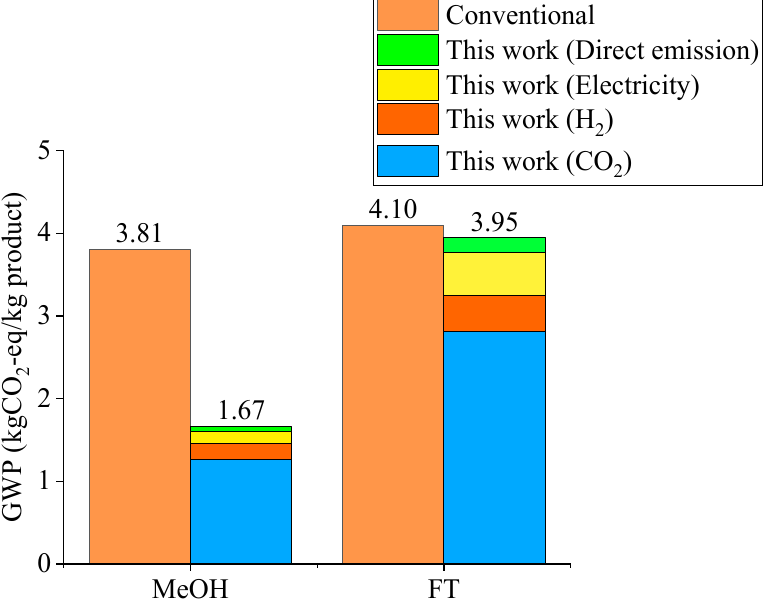
Figure 6. GWP model results comparison with conventional fossil-based methanol production and conventional fossil-based Fischer–Tropsch